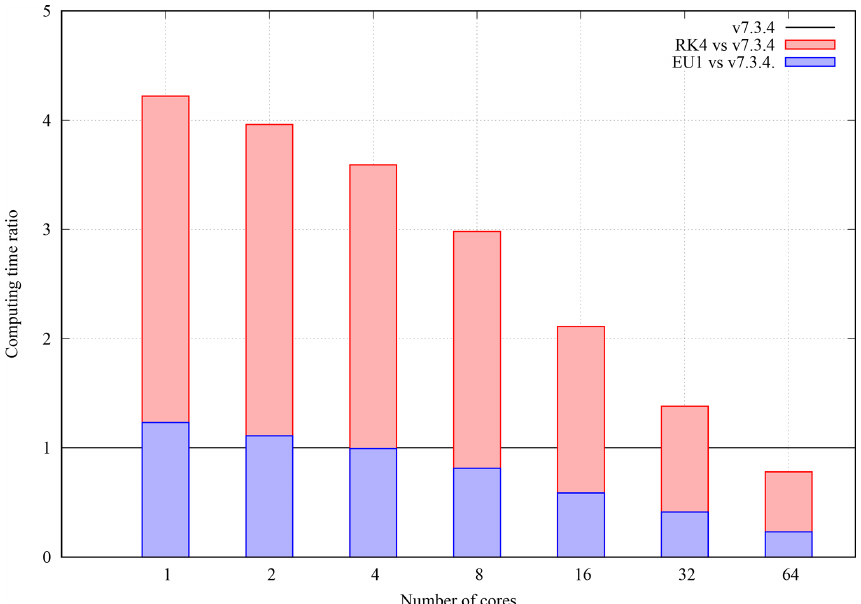
Figure 9. Computing time ratio between code v7.3.4 and v8 depending on the number of processors. Results for EU1 (blue bars) and RK4 (red bars) including I/O operations. Table 13. FALL3D-8.0 model configuration for the Cordón Caulle simulation example shown in Sect.